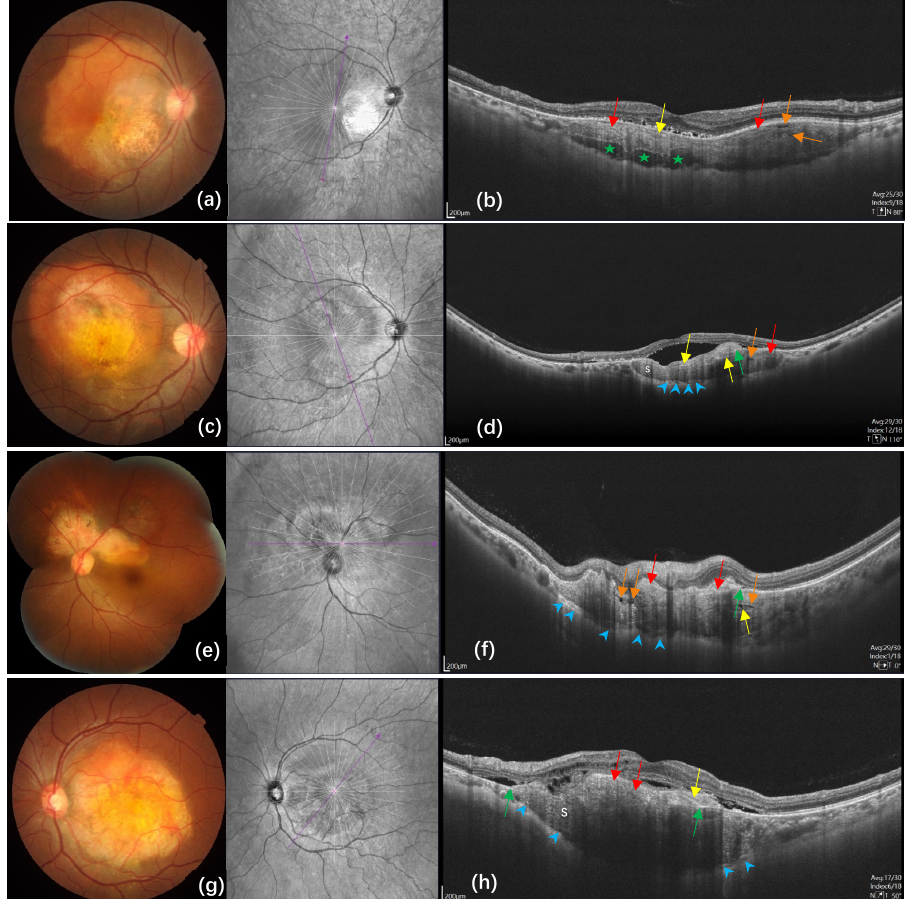
Figure 1. Color fundus photography ( a , c , e , g ) and SS-OCT images ( b , d , f , h ) of patients 14, 19, 2, and 16 (see Table 1), respectively. SS-OCT imaging shows unique features of the CO, including horizontal lamellar lines (red arrows), hyperreflective horizontal lines (yellow arrows), horizontal tubular lamellae with an optically empty center, vertical tubular lamellae (orange arrows), and regions of speckled reflective dots (S). The hyperreflective area is located above the disrupted Bruch’s membrane and contains several intratumor vessels. The sclero-choroidal junction is clearly seen, and vessels between the tumor and the sclero-choroidal junction appear as structures with low or medium internal reflectivity (blue arrowheads, presumed thinning of Haller’s layer that was pushed toward the outside and compressed). The tumor-like hyperreflective tissue is located above the disrupted Bruch’s membrane (green arrows). “Choroidal loculation of fluid” (green asterisks) was also